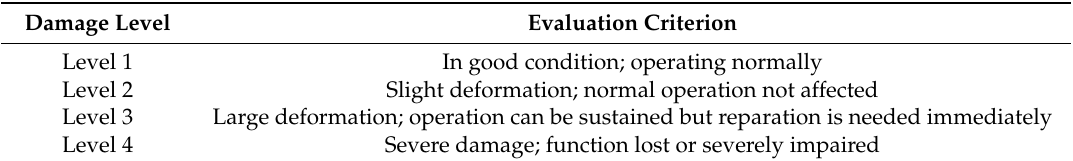
Table 2. The empirical criteria for a damage level evaluation of the river training structures on the Yangtze